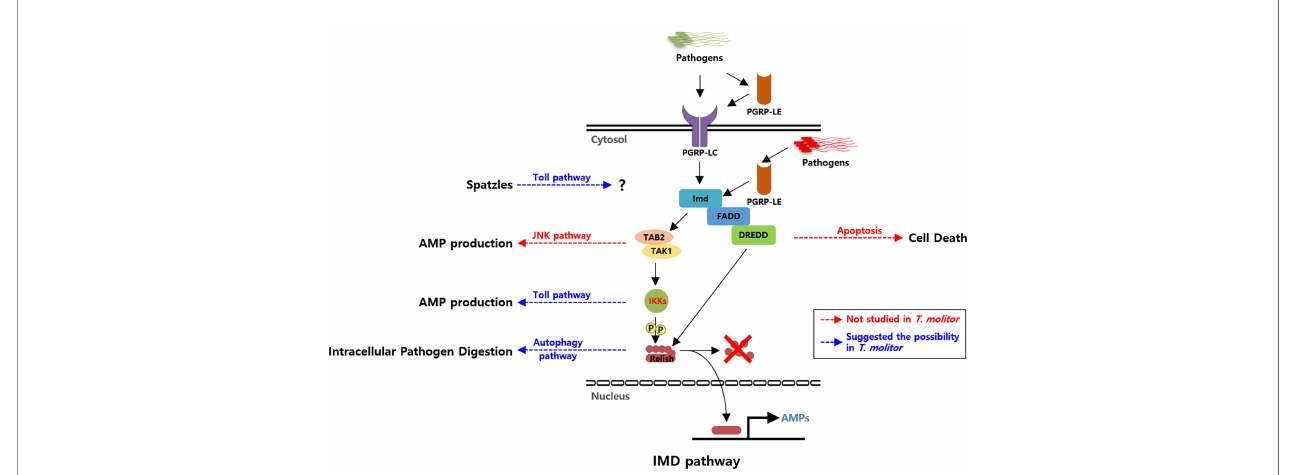
FIGURE 1 | Schematic illustration of the proposed Imd pathway in Tenebrio molitor and its possible cross-talks. Pattern recognition receptors (PRRs; PGRP-LC and PGRP-LE) are triggered by DAP-type PGN of the bacterial cell wall. Recognition of Gram-negative bacteria further triggers the recruitment of intracellular proteins Tm IMD, Tm FADD, and Tm DREDD. Tm TAK1/ Tm TAB2, activated by Tm IMD, further activates Tm IKK complex. Tm Relish is subsequently phosphorylated by the Tm IKK complex and then cleaved by Tm Dredd. Eventually, it leads to the translocation of Tm Relish into the nucleus, where it binds to the relevant transcription response elements and triggers AMP production. Solid black arrows indicate the identi fi ed interactions between Imd signaling compartments. Blue dashed arrows indicate putative cross-talks between Imd and other signaling pathways via Tm IKKs complex, Tm Relish, and ligand Spaetzle in T. molitor . Red dashed arrows indicate the putative cross-talks identi fi ed in other insects. Abbreviations: PGRP; Peptidoglycan recognition protein, IMD; Immune de fi ciency, FADD; Fas-associated protein with death domain, DREDD; death-related ced-3/Nedd2-like protein, TAK1; Transforming growth factor-activated kinase1, TAB2; TAK binding protein 2, IKK; Inhibitor of nuclear factor- k B (I k B) kinase, AMP; Antimicrobial peptide, JNK; c-Jun N-terminal